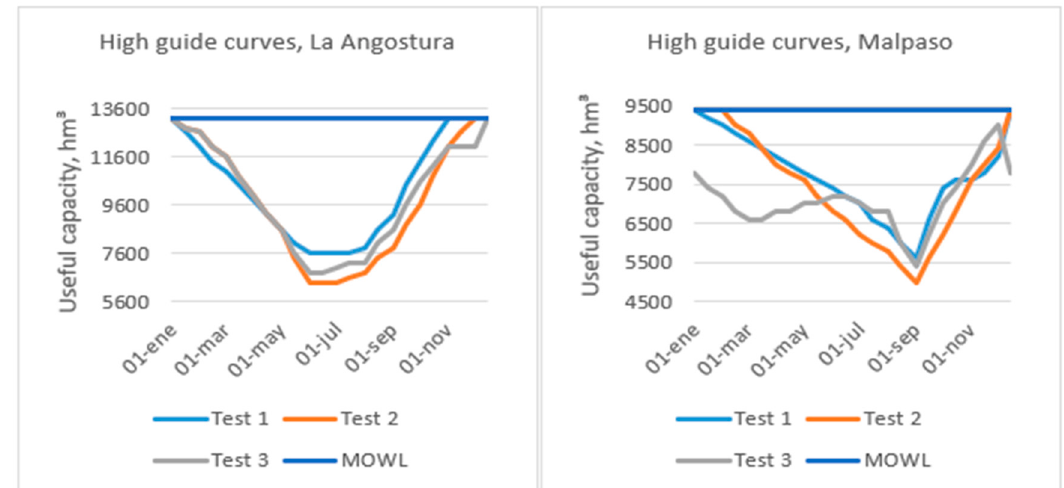
Figure 2. Guide curves tested for La Angostura and Malpaso.